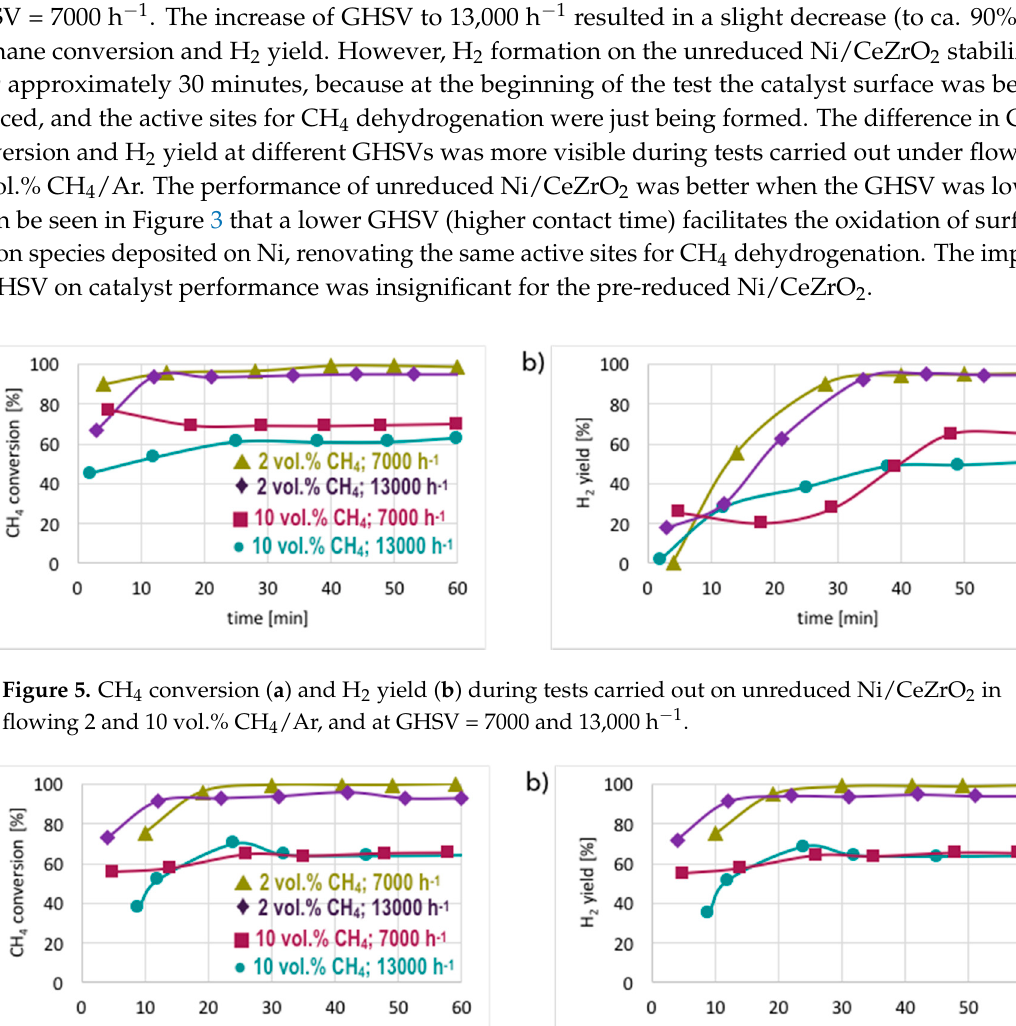
Figure 6. CH 4 conversion ( a ) and H 2 yield ( b ) during tests carried out on pre-reduced Ni/CeZrO 2 in flowing 2 and 10 vol.% CH 4 /Ar, and at GHSV = 7000 and 13,000 h − 1 .